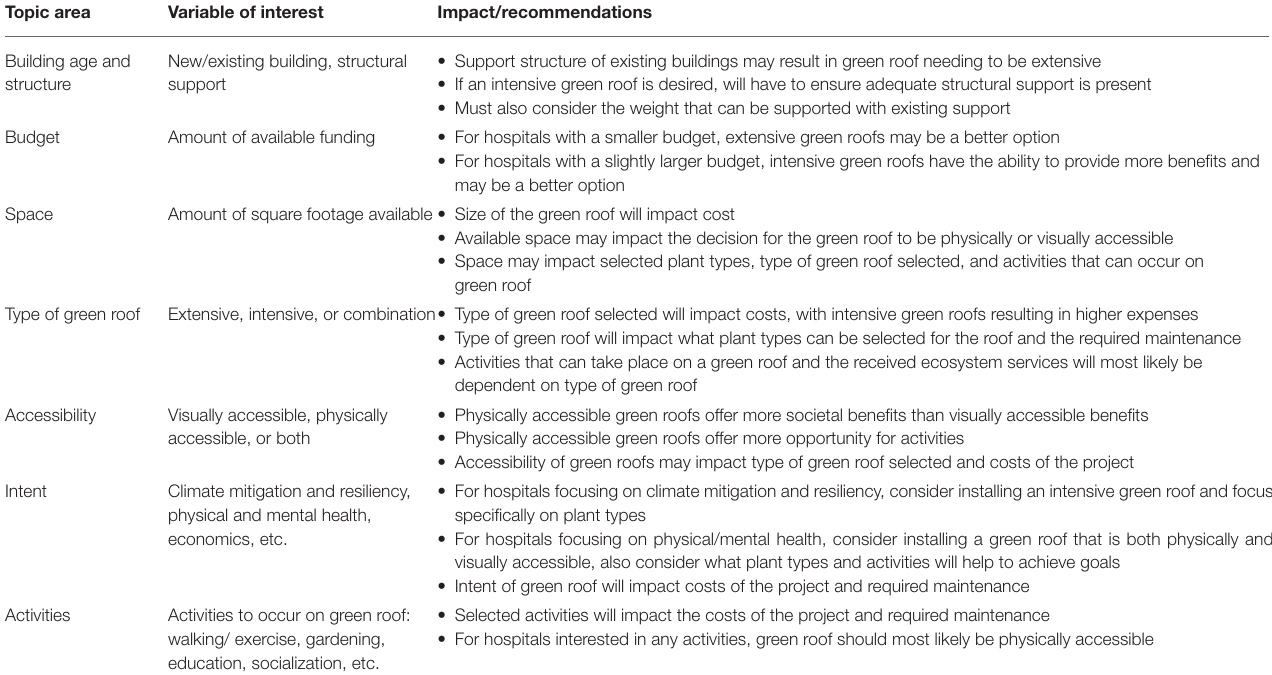
TABLE 4 | Considerations for planning and designing a hospital green